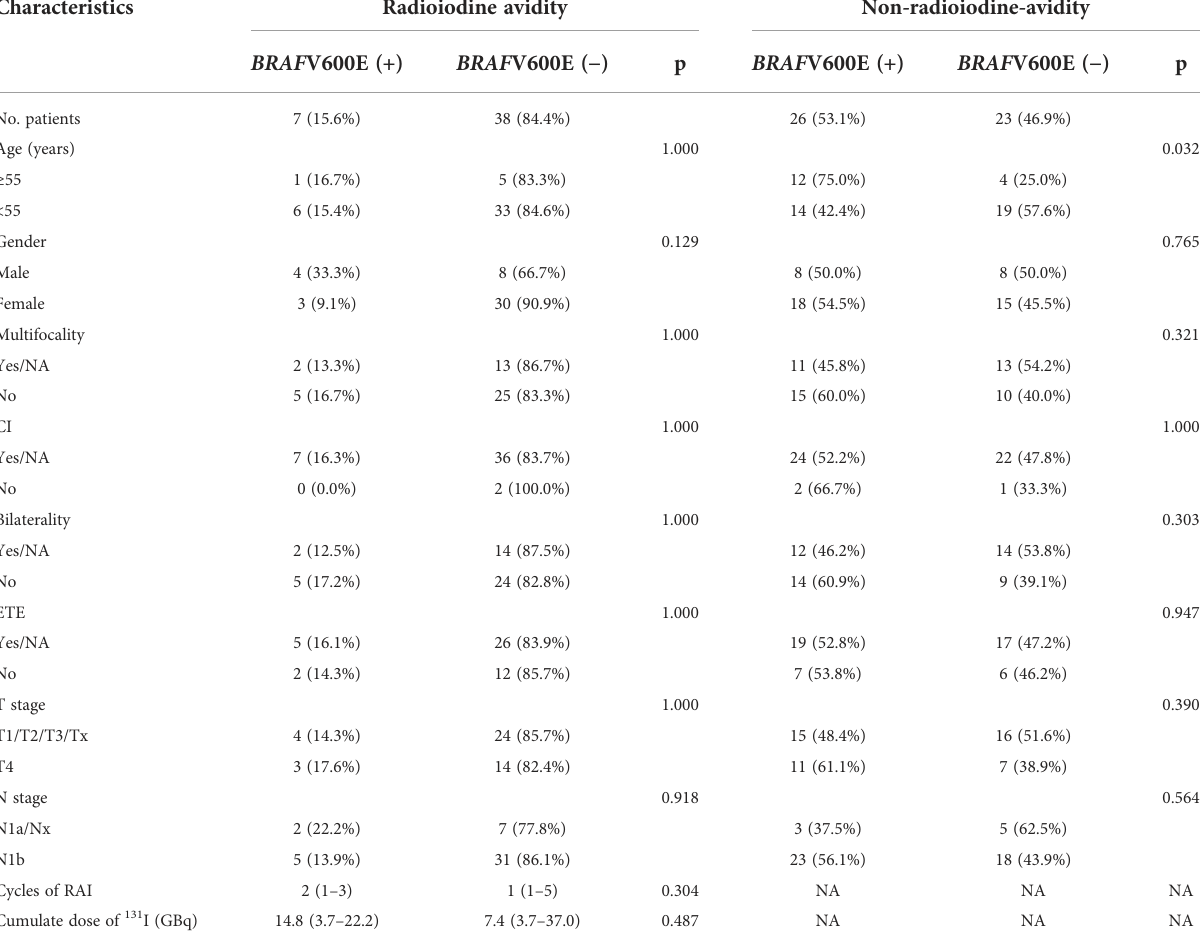
TABLE 3 Clinical characteristics of BRAF V600E(+) and BRAF V600E( − ) patients in radioiodine avidity subgroup and non-radioiodine avidity